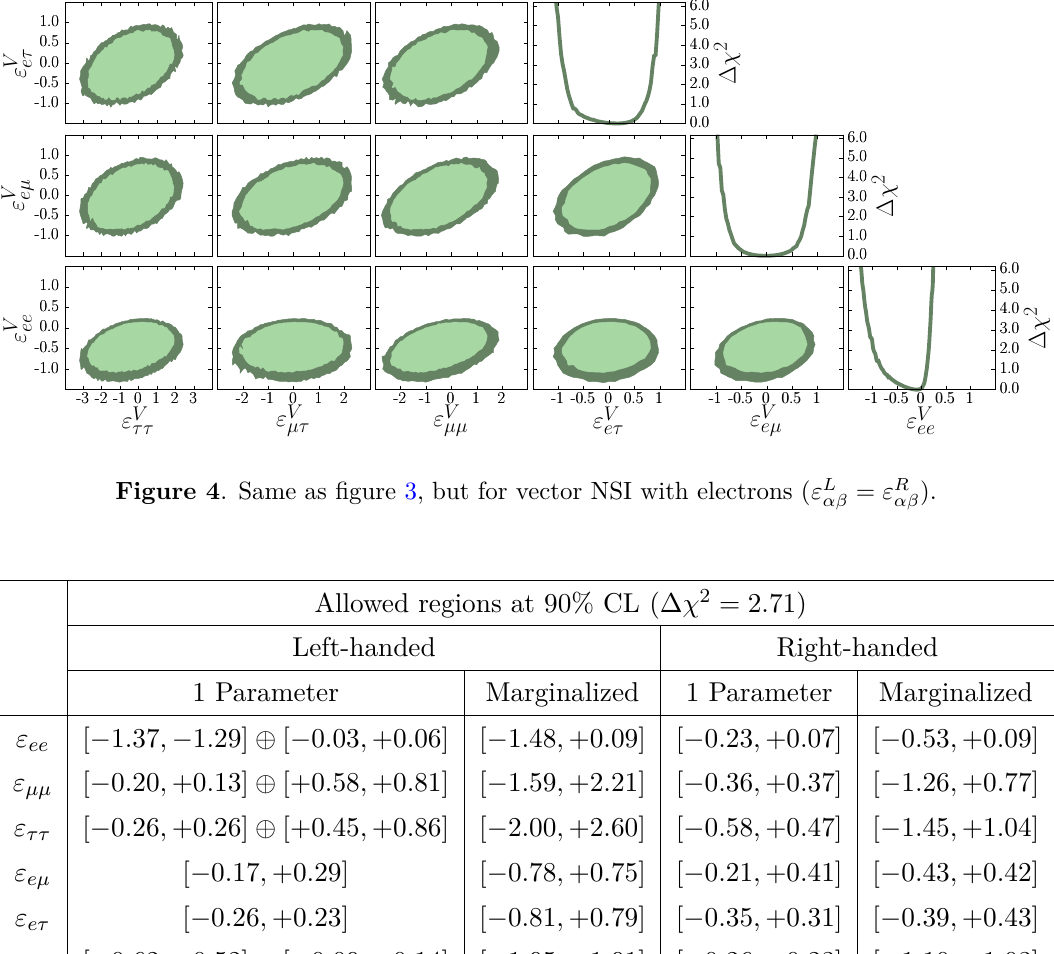
Table 3 . Constraints at 90% CL (for 1 d.o.f., 2-sided) on the coefficients of NSI operators involving only left-handed ( ε L ) or right-handed ( ε R ) electrons. Results are provided separately for two cases: when only one NSI operator is included at a time (“1 Parameter”) or when the remaining NSI coefficients are allowed to float freely in the fit